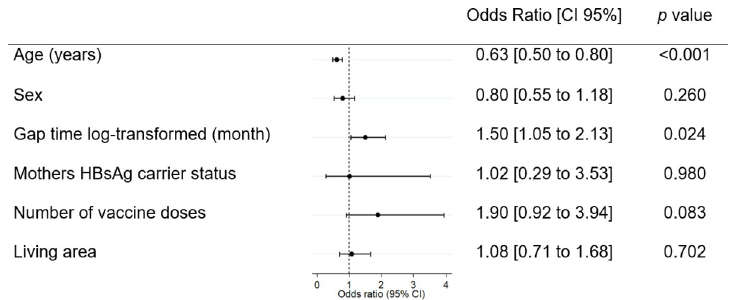
Fig 4. Risk of anti-HBs < 10IU/L by factors associated with low anti-HB levels in a logistic regression